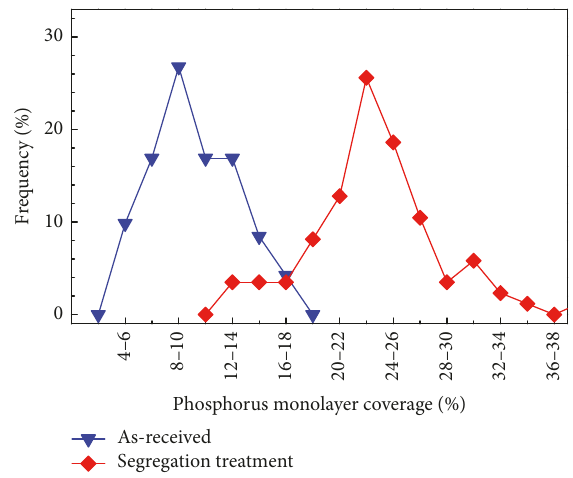
Figure 5: Grain boundary concentration of phosphorus in 15Kh2NMFAA steel specimens: as-received and after segregation provoking treatment.